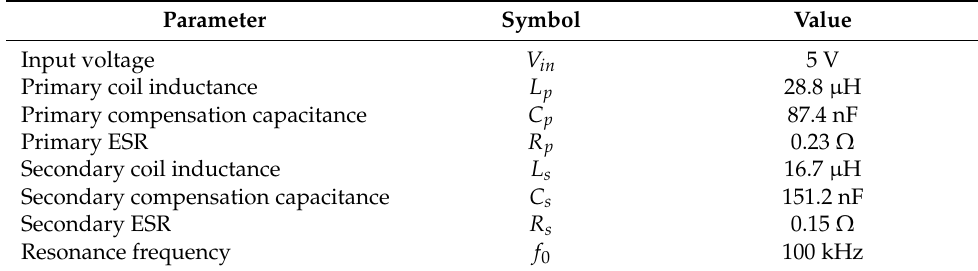
Table 1. System parameters in the position x = 0